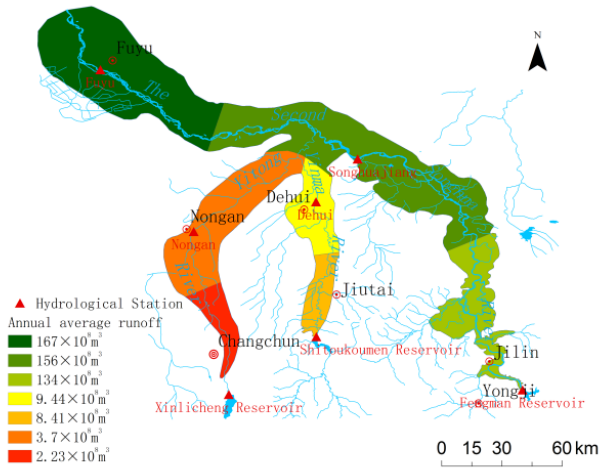
Figure 8. Annual average runoff. Water 2016 , 8 , 176